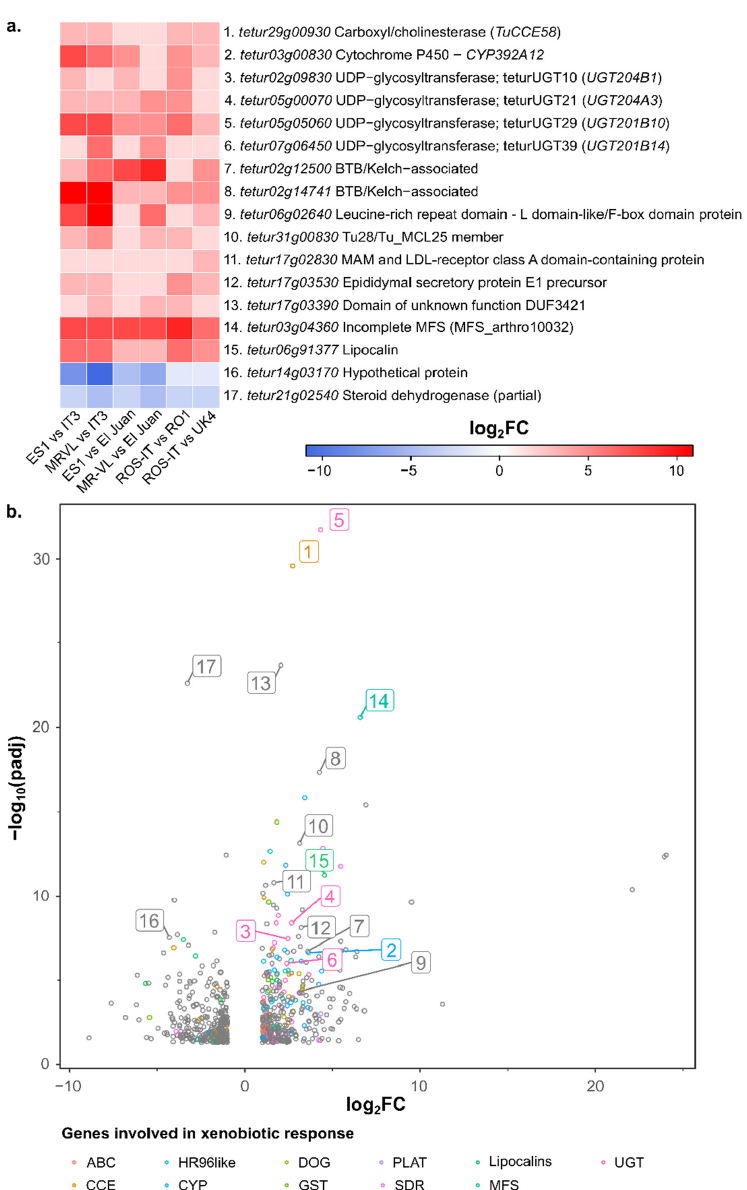
Figure 3. Differential gene expression analysis between bifenthrin-resistant and -susceptible strains. ( a ) Heatmap showing the differentially over- and underexpressed genes that are shared between the six pairwise comparisons (core set of differentially expressed genes). Numbers in the panel cor- respond to the numbers shown in the volcanoplot in panel b; ( b ) Volcanoplot showing the overex- pressed and underexpressed genes (absolute log 2 FC ≥ 1 and p adj < 0.05) in the differential expres- sion analysis between all bifenthrin-resistant and -susceptible T. urticae strains. Differentially ex- pressed genes encoding detoxification enzymes (cytochrome P450 monooxygenases (CYPs), intra- diol ring cleavage dioxygenases (DOGs), increased carboxyl/choline esterases (CCEs), glutathione S-transferase (GSTs), UDP-glycosyl transferases (UGTs)), transporters (ABC transporters (ABCs) and Major Facilitator Superfamily (MFS)), lipocalins, nuclear hormone receptor family 96 (HR96) lacking DNA binding domain (HR96like) [66] , short-chain dehydrogenases/reductases (SDRs) or PLAT domain proteins (PLAT) are color-coded according to the legend shown below the plot.